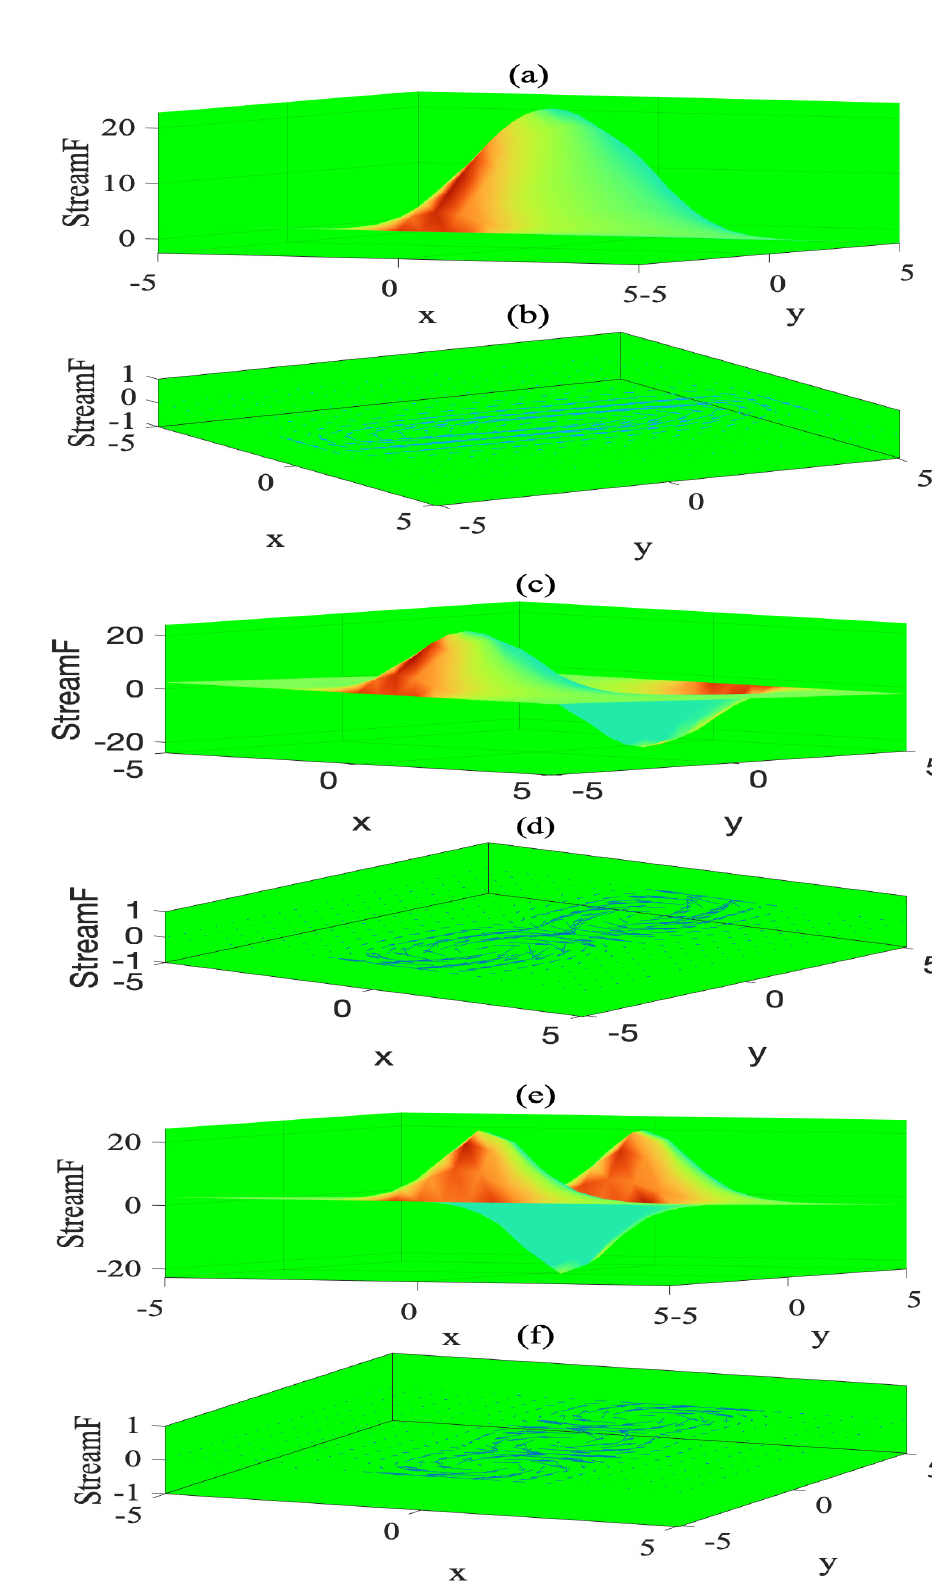
Figure 2. The Soliton-type vortex monopole ( a , b , with parameter n = 1), vortex dipole ( c , d , with parameter n = 2), and vortex tripole ( e , f , with parameter n = 3), expressed by stream function solution (23) with its other parameters chosen as: (cid:101) = 0.25, c = 0.5, ¯ u = 0.5, k = 1, α = 2, γ = 2.5, δ = 4, µ = 3, T = 0.25, b 2 = − 1, b 1 = − 3, b 0 = 1, y 1 = − 5 and y 2 =